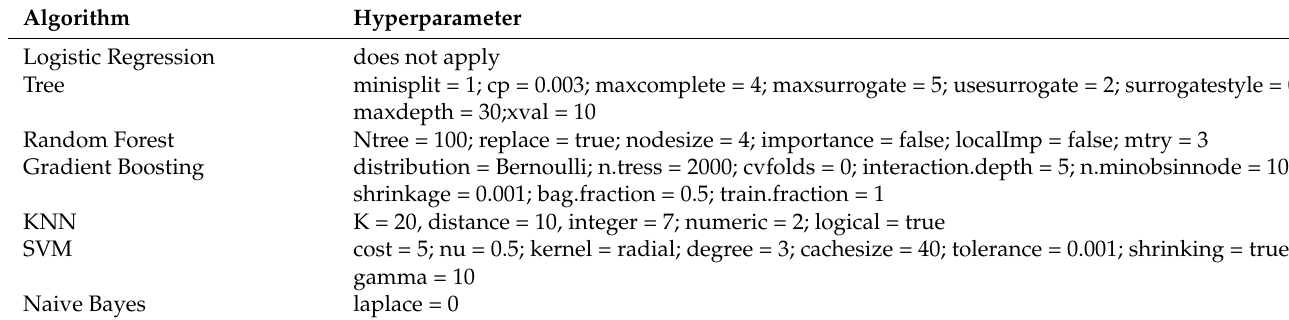
Table A1. Final hyperparameters for model building during nested cross-validation 1